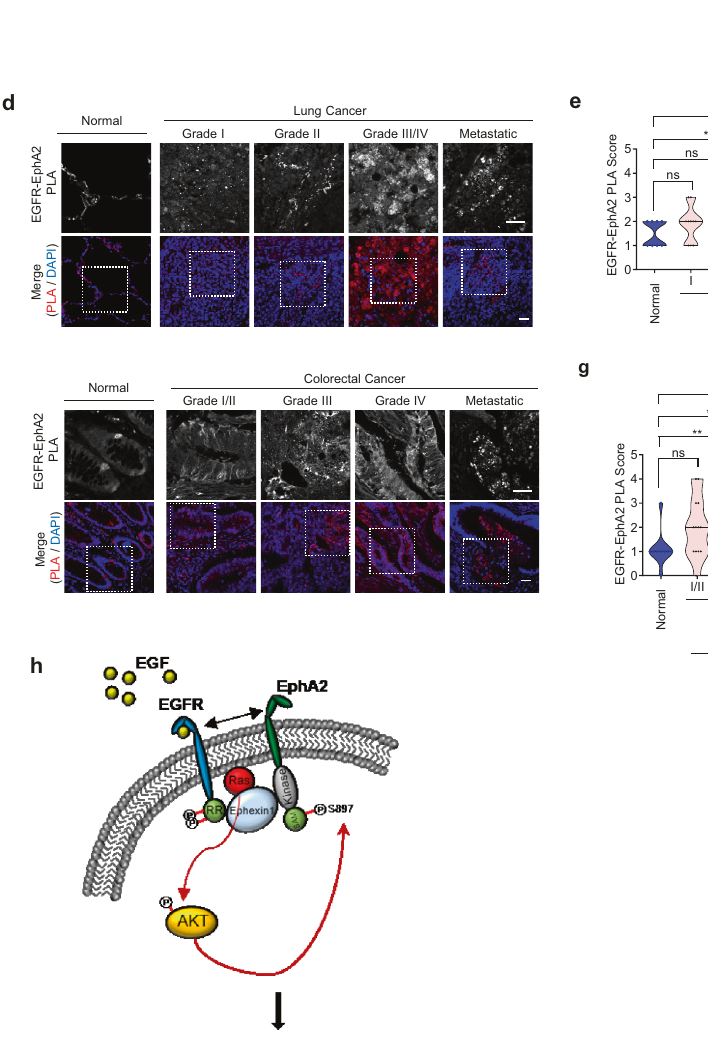
with control cells. However, in an Ephexin1-de fi cient cell background, overexpression of the two proteins did not lead to an increase in tumor size (Fig. 5f, g). These results suggest that the levels of Ephexin1 regulate the oncogenic functions of EphA2 and